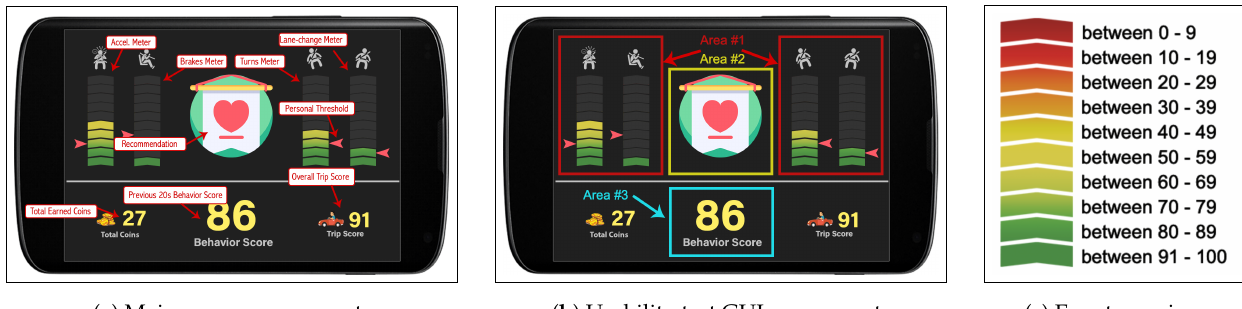
Figure 7. GUI components’